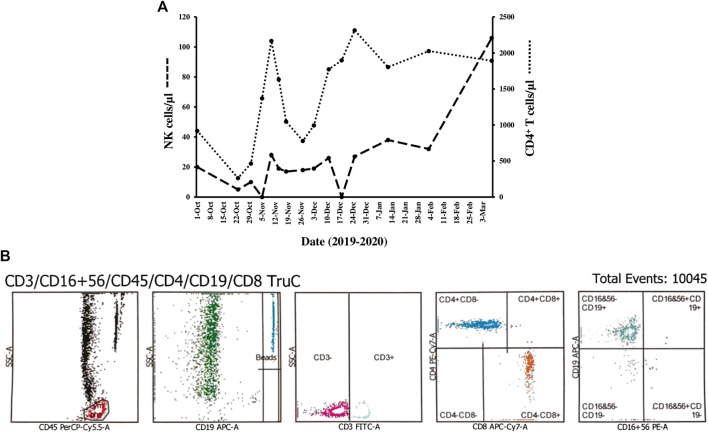
In (A), changes in counts of CD3−CD56+CD16+ NK cells and CD4+ T cells are plotted over time. Serial measurements of circulating NK cells/μl (y-axis left; dashed line) and CD4+ T cells/µl (y-axis right; dotted line) by flow cytometry disclosed a persistent, severe numerical NK cell deficiency (mean 18.5 ± 11.5 cells/µl, reference range 100–645 cells/µl), whereas CD4+ T cells initially fell to 264 cells/µl on the second day of admission (October 23) and fluctuated considerably within reference range thereafter (mean 1,389 ± 650 cells/µl, reference range 322–1750 cells/µl). NK cell counts returned to normal levels (106 cells/µl) at the end of the observation period. In (B), a representative example of flow cytometry histograms using standard gating strategy is shown. CD45+/SSC gate was applied to identify peripheral blood lymphocytes, followed by CD19+/SSC, CD3+/SSC, CD8+ vs. CD4+ subsets and finally CD19+ vs. NK cells identified as CD3−CD19−CD56+ CD16+ lymphocytes, which were nearly absent (histogram #5).